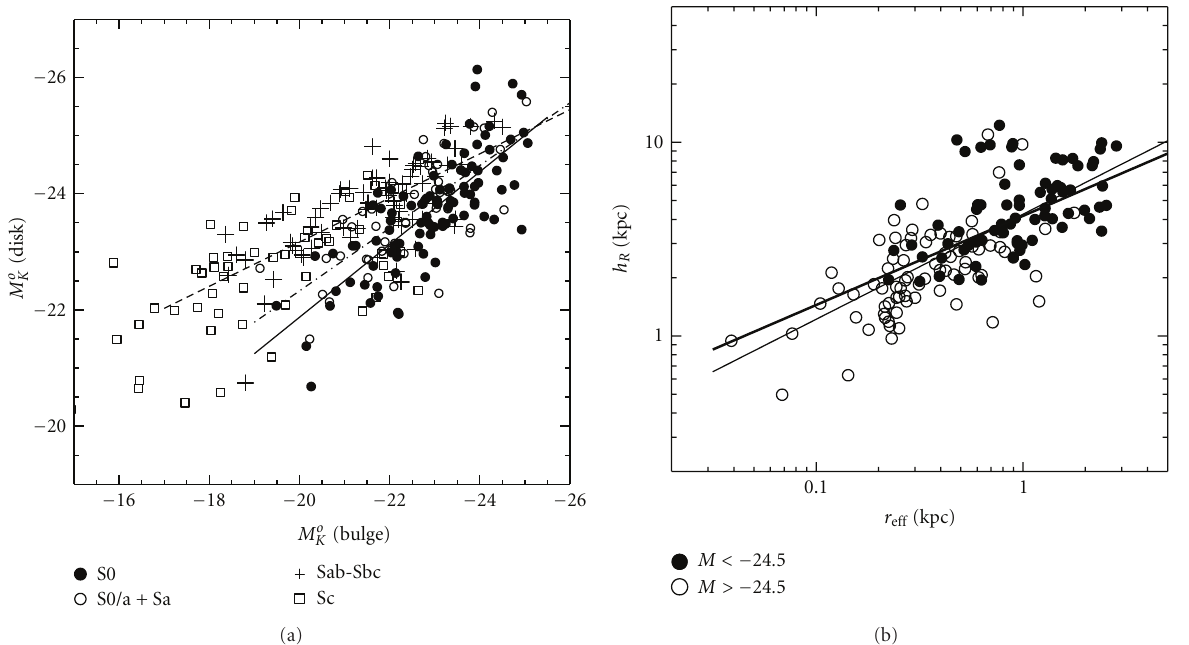
Figure 11: (a) the absolute brightness of the disk ( M o (disk)) is plotted against the absolute brightness of the bulge ( M o K (filled circles), S0/a+Sa (open circles), Sab-Sbc (crosses), and Sc and later types (squares). Solid, dash-dotted, and dashed lines show linear fits for the S0s, S0/a+Sa, and Sab-Sbc galaxies, respectively. All the correlations are statistically significant. (b) h R (disk) versus r e ff (bulge) for the galaxies in NIRS0S, divided to two galaxy brightness bins in K s -band. This figure is compiled from two figures originally published by Laurikainen et al. [27,